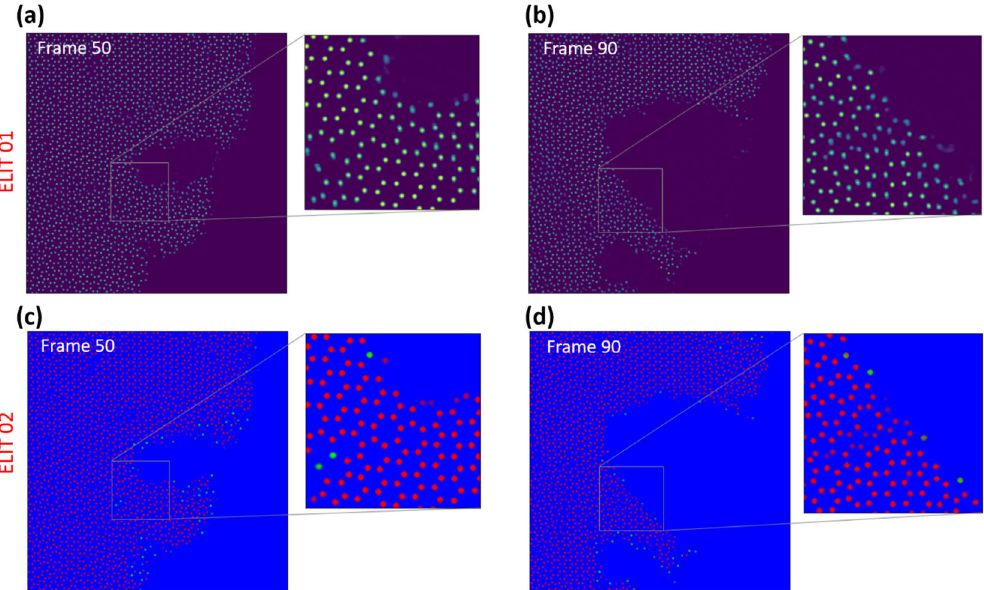
Fig. 4 Mean ensemble predictions after re-training with subsets of experimental data. a , b Mean DL prediction (semantically segmented map) from the ensemble after the fi rst re-training using only frames from the beginning of the movie. c , d Prediction (semantically segmented map) after second retraining using multi-class segmentation masks with training data randomly sampled from the entire